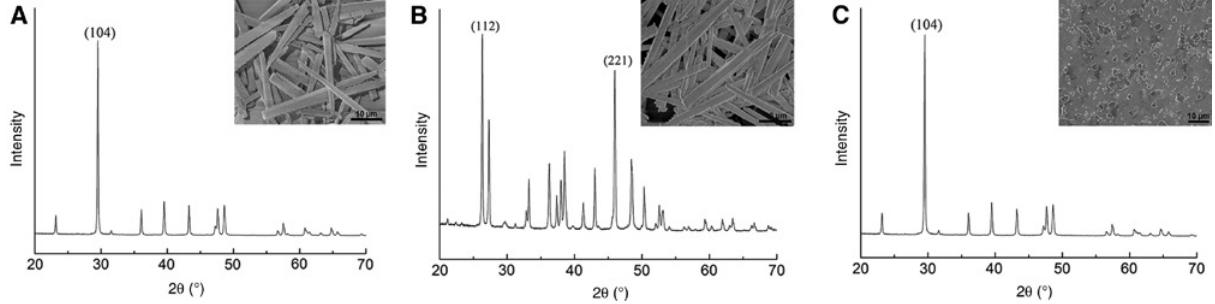
Figure 1: XRD pattern and FESEM micro-morphology: (A) calcite whiskers, (B) aragonite whiskers, (C) calcite particles.